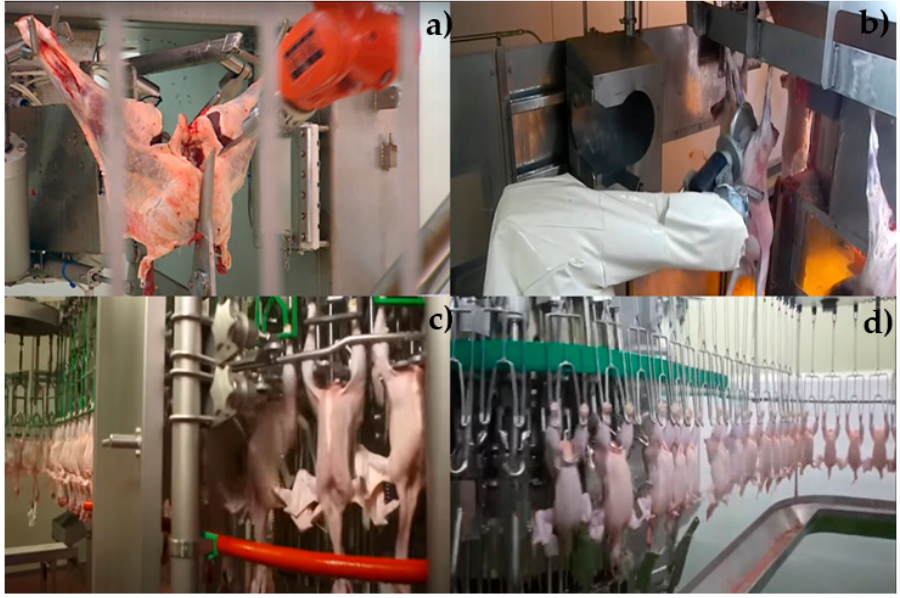
Figure 3. Robotics and automation in the meat sector (( a ) bovine hindquarter cut; ( b ) lamb ventral cut; ( c , d ) automated poultry line).